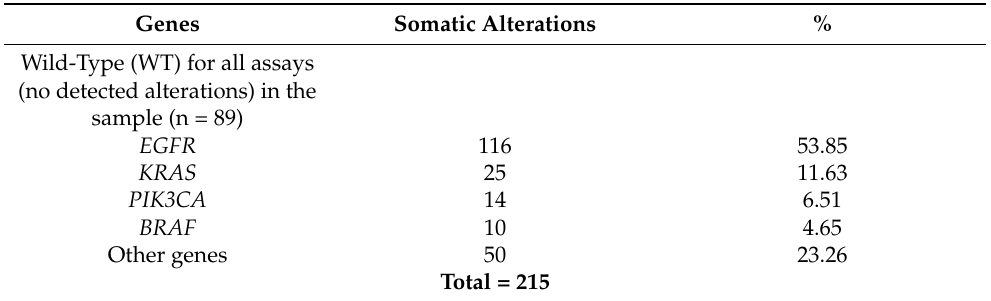
Table 1. cfDNA characteristics of the population and percentages (%) of the mutation per gene found in the cohort. Genes Somatic Alterations % Wild-Type (WT) for all